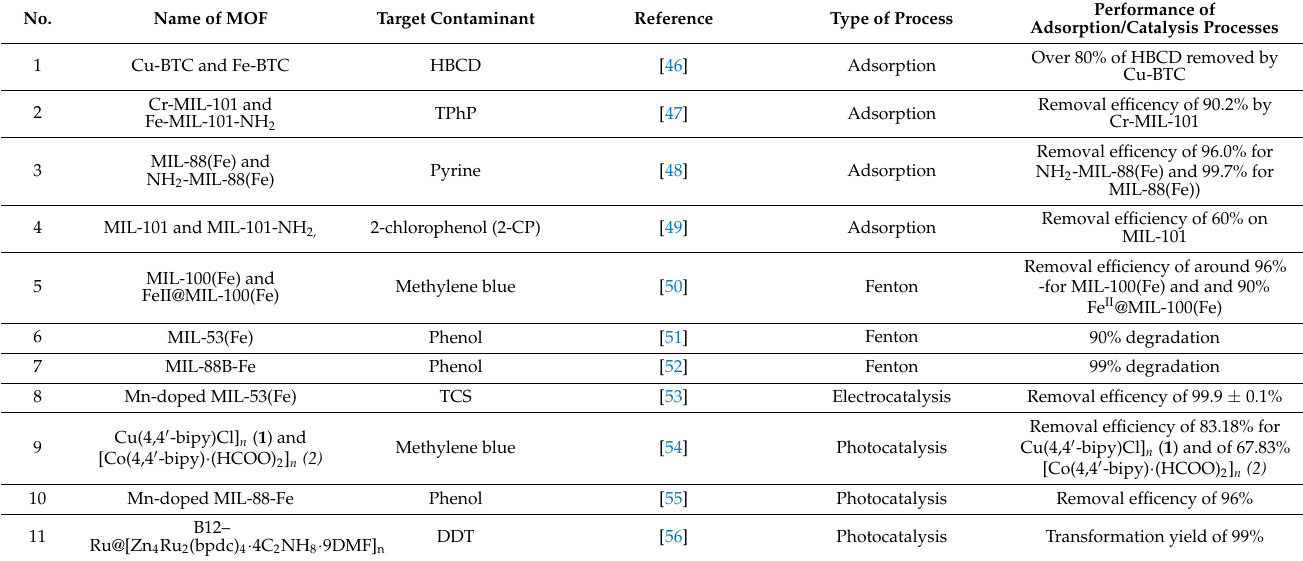
Table 2. Summary of adsorption and catalysis studies for relevant priority and emerging organic